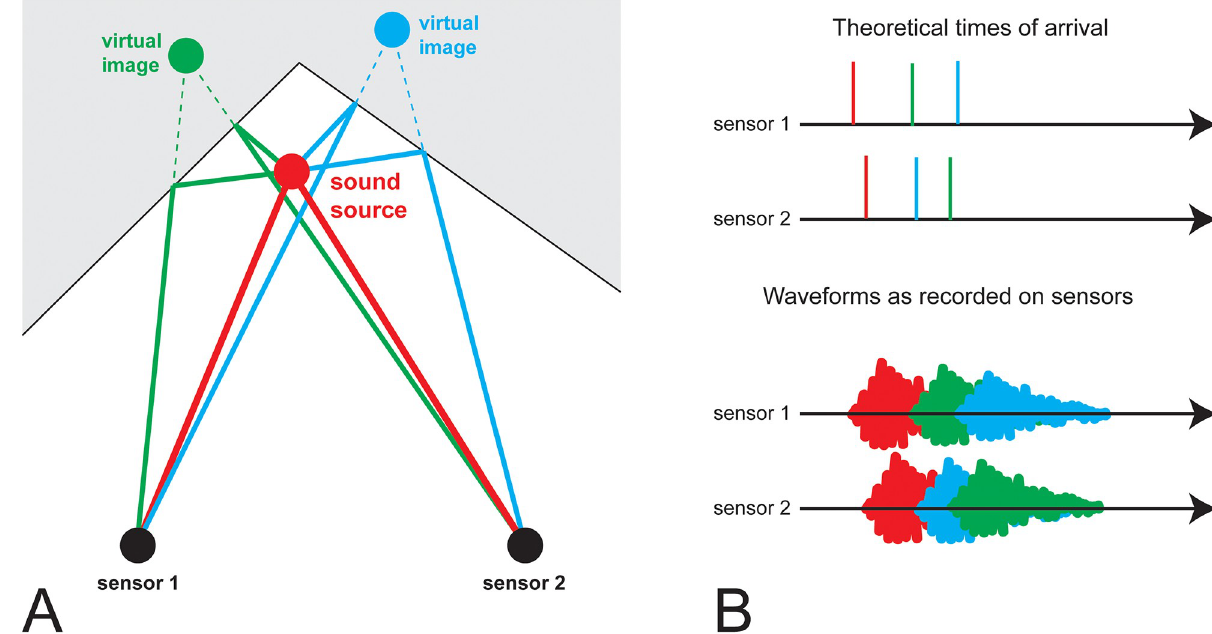
Fig 1. Cartoon depiction of a sound’s arrival at sensors in a reflective environment. (A) Sound originates from a source and arrives at two sensors, both directly (red paths) or bouncing on walls (green and blue). The sound bouncing off the walls arrives at the sensors at angles and delay times matching what would have happened if the sound had originated at a “virtual image”, located at the mirror reflection of the source on the corresponding wall. (B) The arrival times of the sounds at each sensor; because the source is slightly to the left the direct incidence (red) arrives just slightly earlier at sensor 1; because the left image (green) is to the left that echo arrives much earlier at sensor 1 than 2, and because the right image (blue) is to the right, that echo arrives much earlier at sensor 2 than 1. If the sounds were purely impulsive then the first incidence would always be clear, but matching later echoes requires computation. However, if the sounds are longer than the typical distance between echoes, then the recorded waveform contains overlapping pieces, and any particular method of computing TOA (e.g. by cross-correlation) may give erroneous results due to the echoes arriving in a different temporal order at each